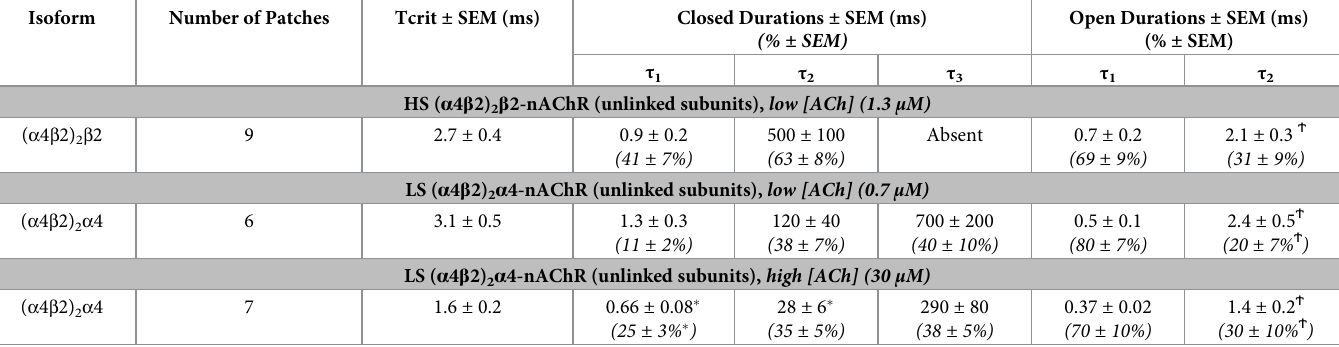
Table 1. Closed and open dwell duration parameters for human high sensitivity (HS) and low sensitivity (LS) α 4 β 2-nAChR isoforms expressed using unlinked subunits.